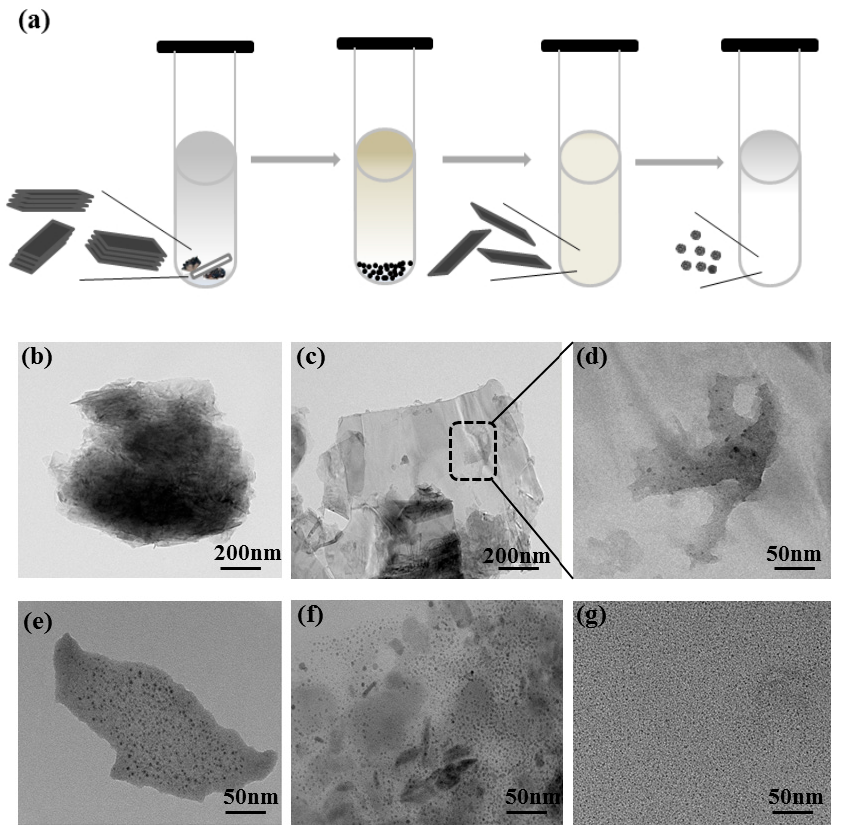
Figure 2. ( a ) Schematic of bulk BP used to synthesize black phosphorus quantum dots (BPQDs) in ethanol using a microwave (MW)-assisted technique. TEM images of intermediate BPQDs at different disintegrating times: ( b ) MW-1 at 11 min, ( c ) MW-2 at 5 min, ( d ) magnified image from (c), ( e ) MW-2 at 10 min, ( f ) MW-2 at 20 min, and ( g ) MW-2 at 30 min.